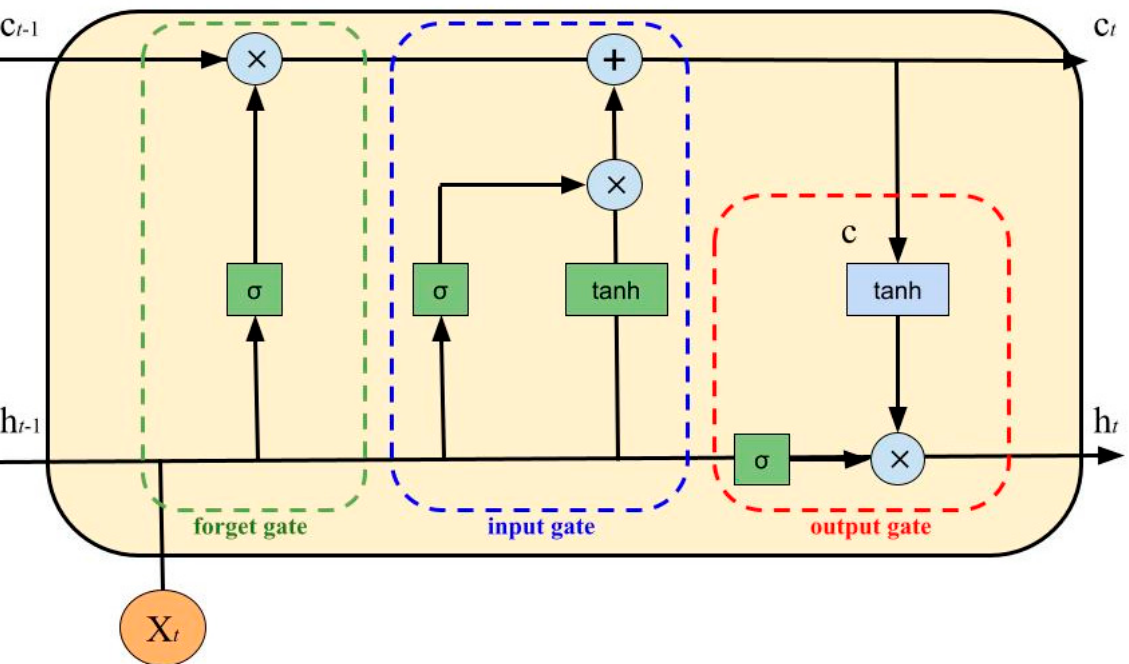
Figure 2. An LSTM cell, where σ is the sigmoid function.